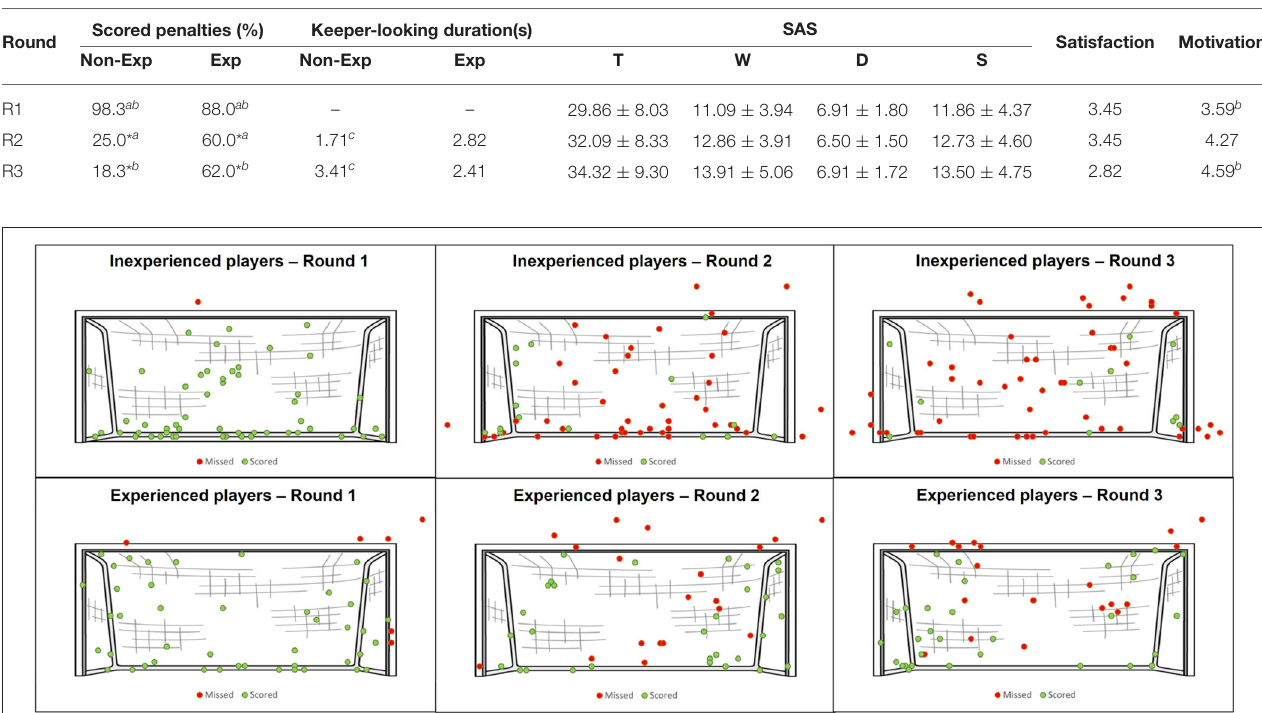
FIGURE 3 | Overview of the placement of penalty-kick execution for experienced and inexperienced players in each round. Red dots represent missed penalties and green dots represent scored penalties.